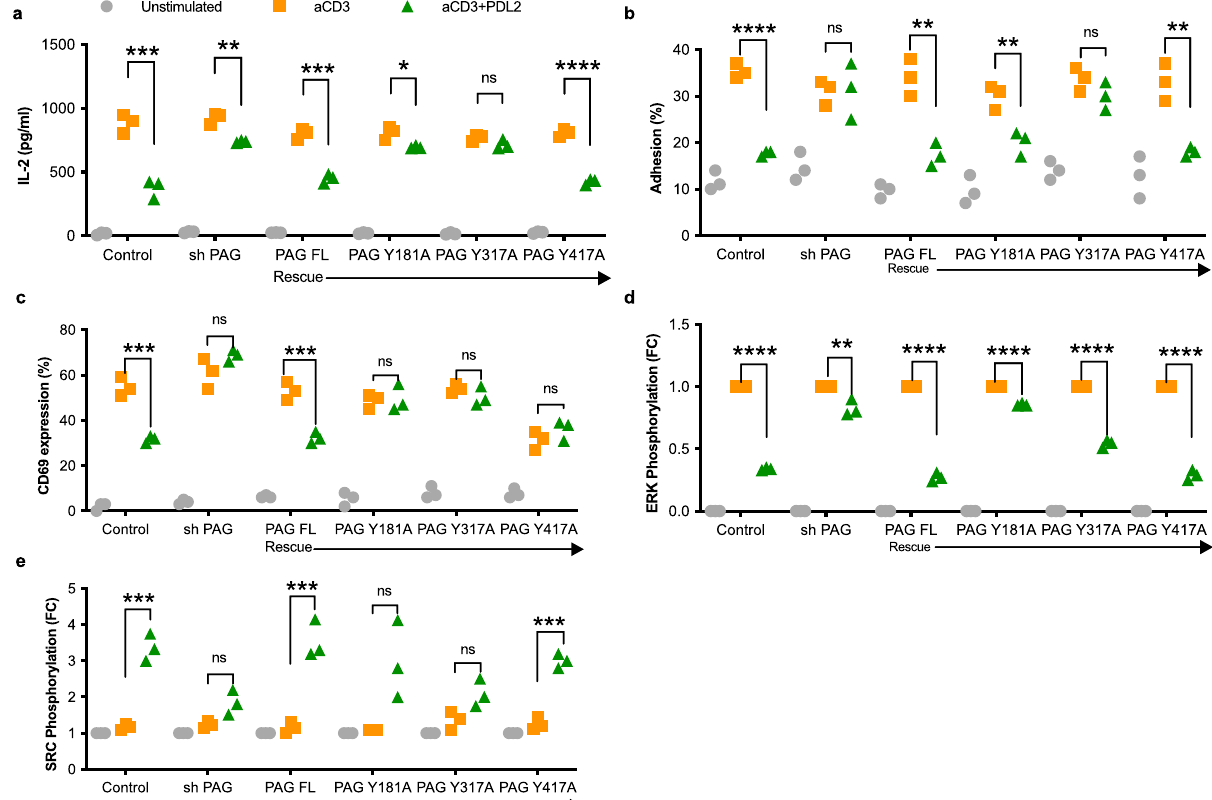
Fig. 3 PAG is required for PD-1 signaling and function. a ELISA of secreted IL-2 in the supernatants of Jurkat cells collected 24 h following stimulation